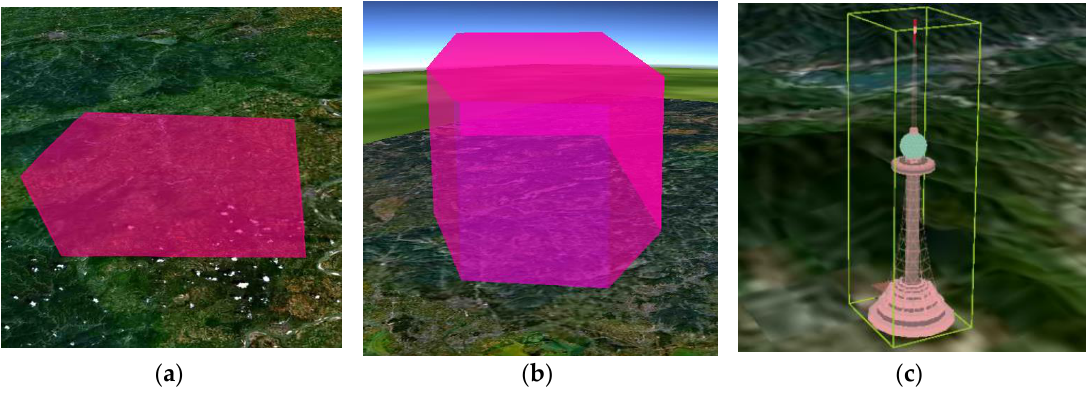
Figure 3. ( a ) 2D No-fly zone; ( b ) 3D slowly hazardous weather model; ( c ) 3D threat model of a 500-m high TV tower described as {(114.655225, 23.269952), (114.658225, 23.269952), (114.658225, 23.272952), (114.655225, 23.272952), 500}.